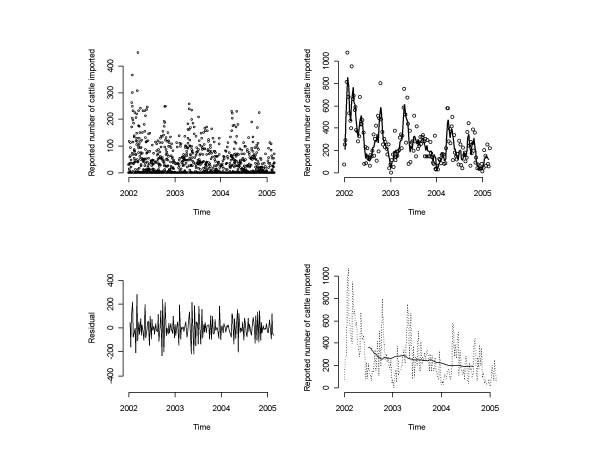
Time series for cattle imports reported to BCMS over the period 1st Jan 2002 and 28th Feb 2005. (a) Raw data plotted at daily intervals (b) 3-point moving average (raw weekly data shown as unconnected symbols) (c) Residuals after accounting for the 3-point moving average (d) 53-point moving average (raw weekly data shown as unconnected symbols).